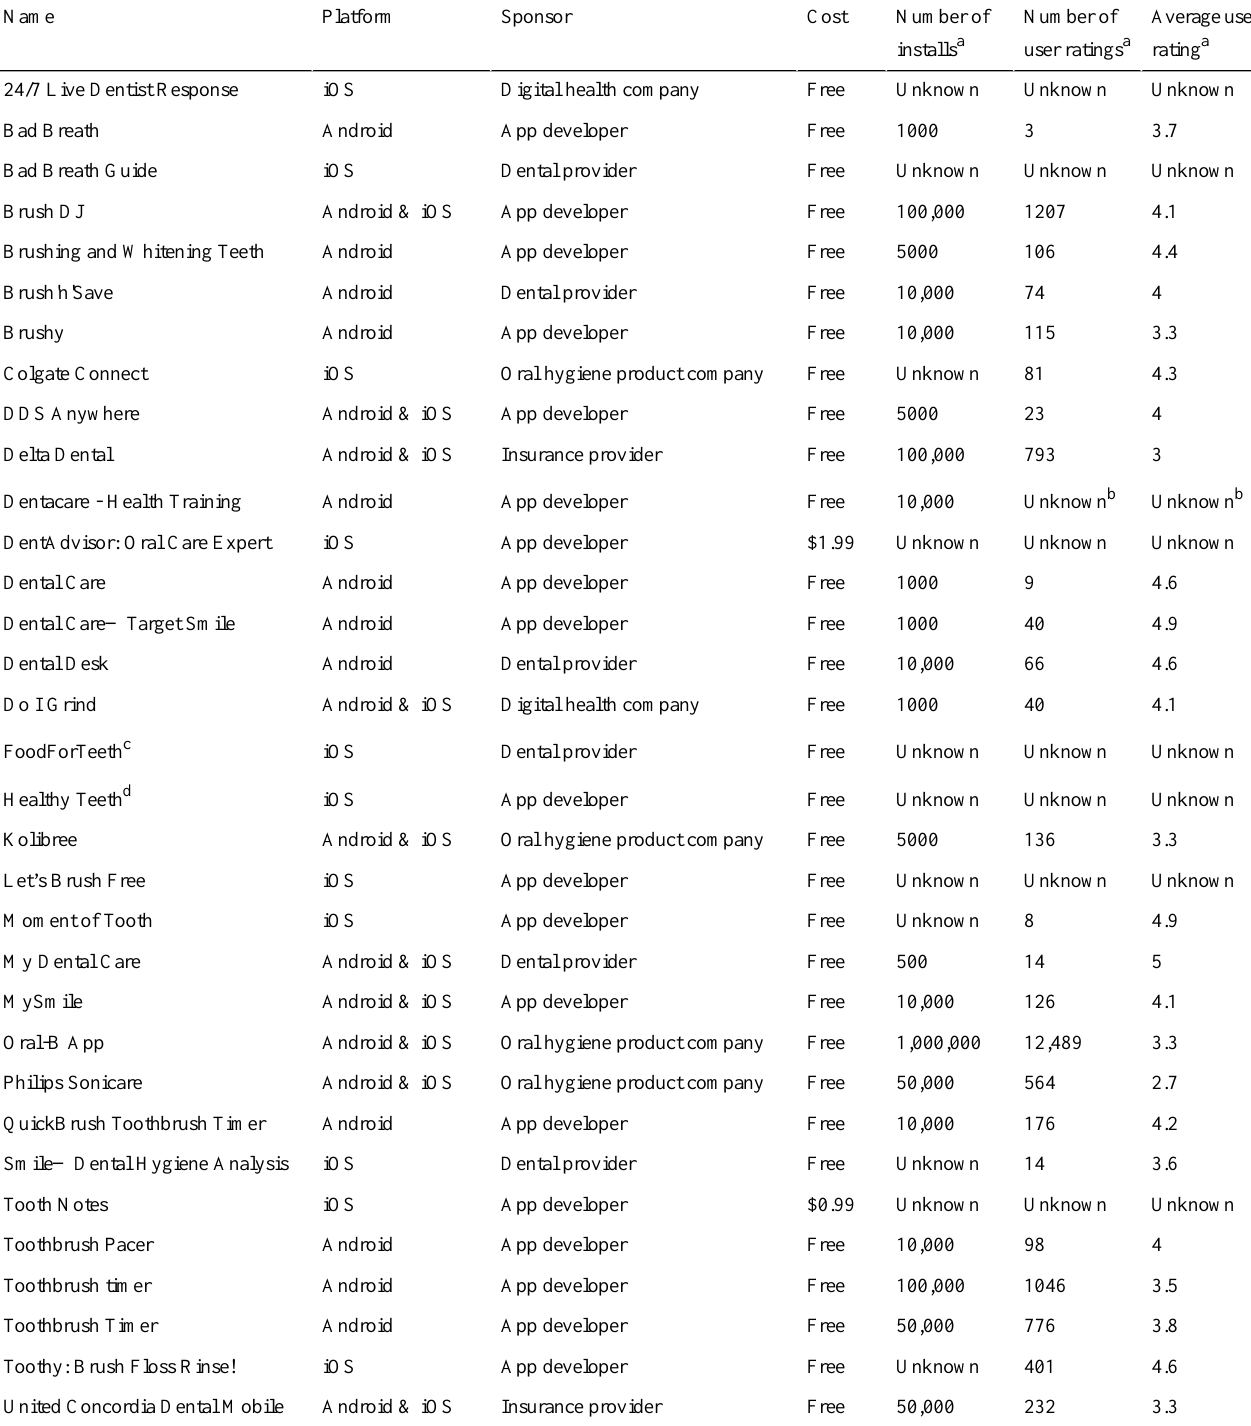
Table 2. Reviewed